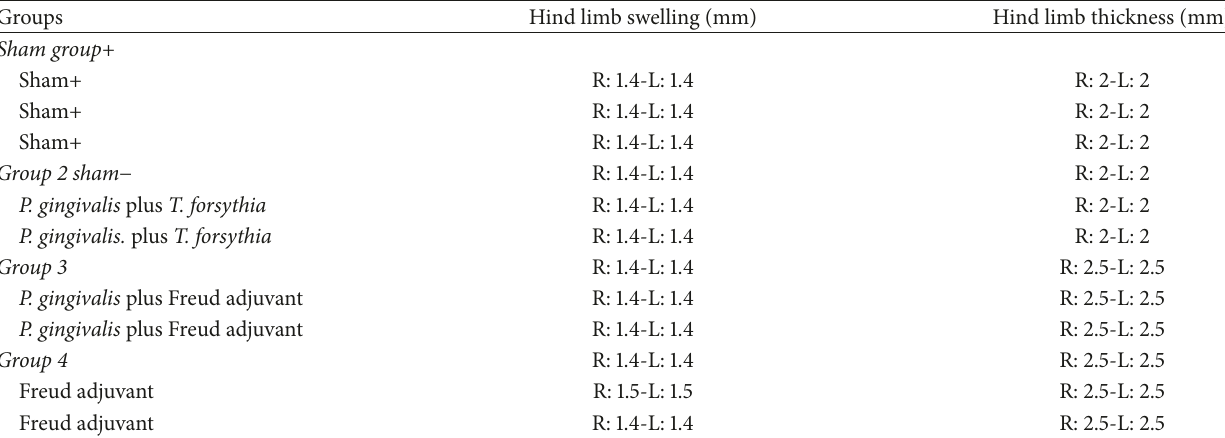
Table 1: Inflammatory response of the hind limbs of Balb/c mice. Groups Hind limb swelling (mm) Hind limb thickness